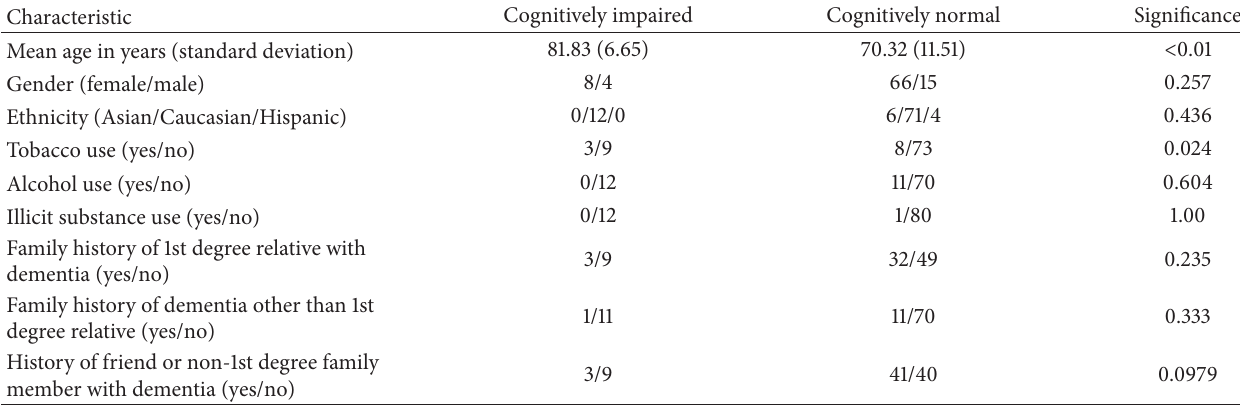
Table 1: Demographic characteristics of memory screening participants.